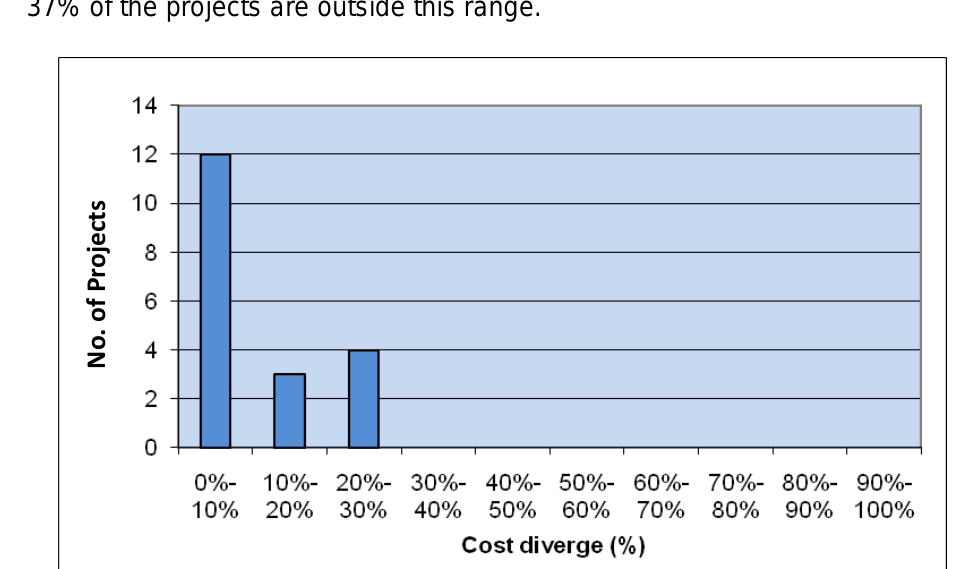
Figure 10 Cost over estimation vs. no of large sized road construction